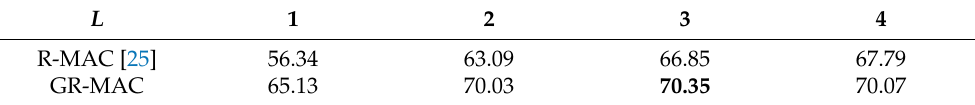
Table 8. The result with different scale size L . The maximum value is in bold.